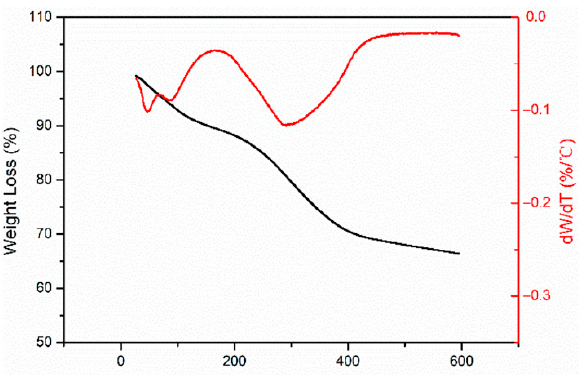
Figure 3. Thermogravimetric weight loss curve and derivative plots of 0.01BiMnMgAl − HT . The H 2 -TPR images of samples are shown in Figure 4. For the uncalcined xBiOCl/MnMgAl-HT, two hydrogen consumption peaks were found at about 300 °C and 450 °C, which could be attributed to the redox process of Mn. The former could be assigned to the hydrogen consumption peak of Mn 4+ to Mn 3+ , while the latter might be due to the hydrogen consumption peak of Mn 3+ to Mn 2+ . With regard to the peak area of the two characteristic peaks, the latter is much larger than the former. This indicated that Mn 3+ and Mn 4+ exist together in uncalcined xBiOCl/MnMgAl-HT, of which Mn 3+ is the dominant state. In contrast, for the calcined xBiOCl/MnMgAlO, only one hydrogen consumption peak appeared at about 410 °C, suggesting the presence of single Mn 3+ due to the redox of Mn 4+ to Mn 3+ during calcination. Moreover, xBiOCl/MnMgAlO showed a lower reduction temperature of Mn 3+ than xBiOCl/MnMgAl-HT. It was accepted that the shifts of hydrogen consumption peaks to lower temperatures were ascribed to the